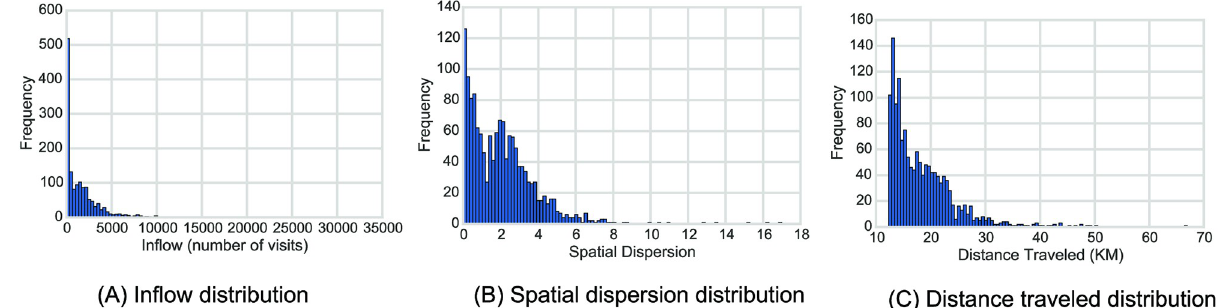
Fig 3. The distribution of attraction features. (A) shows the total inflow received by TAZes in Riyadh. The majority of places receive low to medium inflow, while a few places receive very high inflow, making them highly attractive. (B) Shows the distribution of spatial dispersion, and (C) shows the distribution of distances traveled on the road